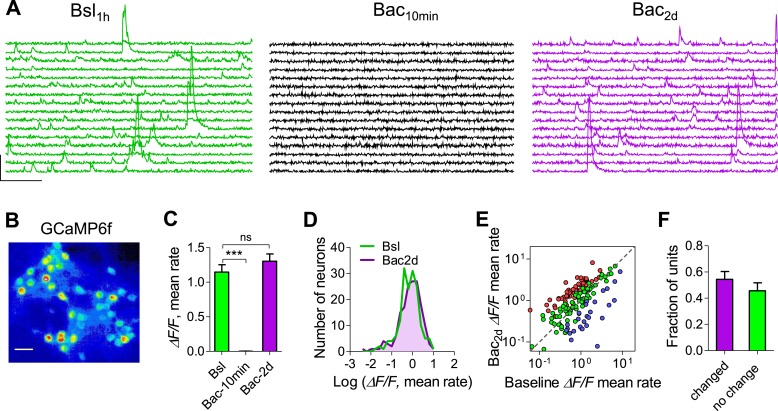
Calcium imaging confirms more precise homeostatic regulation of firing rates at the network, than the single-unit level.(A) Representative traces (ΔF/F) showing the same 16 neurons before, 10 min after 10 µM baclofen application, and after 2 days in the presence of baclofen. Bar scales: 50% ΔF/F, 5 s. (B) Pseudo-color coded image showing cultured neurons expressing GCaMP6f. Scale bar: 50 µm. (C) Summary of the mean rate (averaged peak amplitude per min) before (green), after 10 min (black) and following 2 days (purple) of baclofen application. Population mean rates were restored after 2 days (n = 4, 192 neurons). (D) Distribution of neuron ΔF/F rates (log scale) during baseline and after 2 days in the presence of baclofen. (E) Per neuron correlation between baseline firing rates and firing rates after 2 days in the presence of baclofen (n = 4; 192 neurons). Colors represent neurons that significantly increased (red), decreased (blue), or remained stable (green) as determined by bootstrapping. Note log scale of both axes. (F) Summary of data in E (54.3% ± 6 cells were significantly changed). Error bars represent SEM.